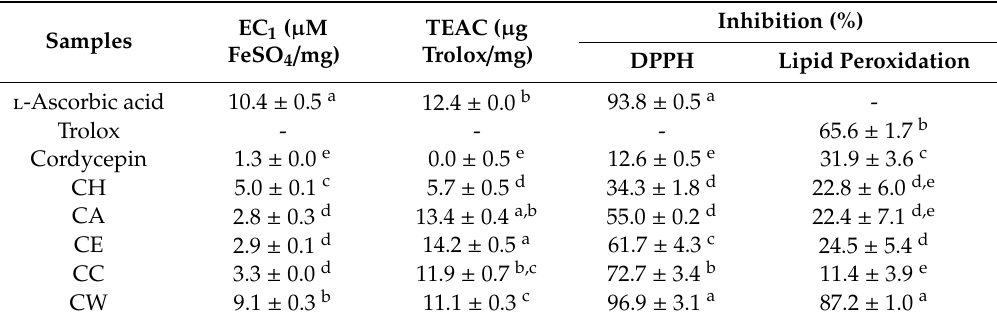
Table 3. Antioxidant activities of C. militaris